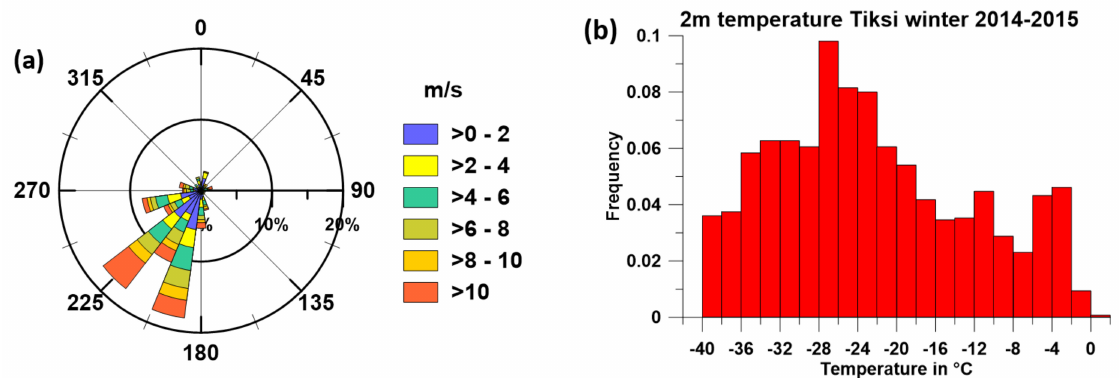
Figure 3. ( a ) Wind rose for the 10 m-wind during the investigation period (15 ◦ bins). ( b ) Frequency distribution of the 2 m-temperature during the investigation